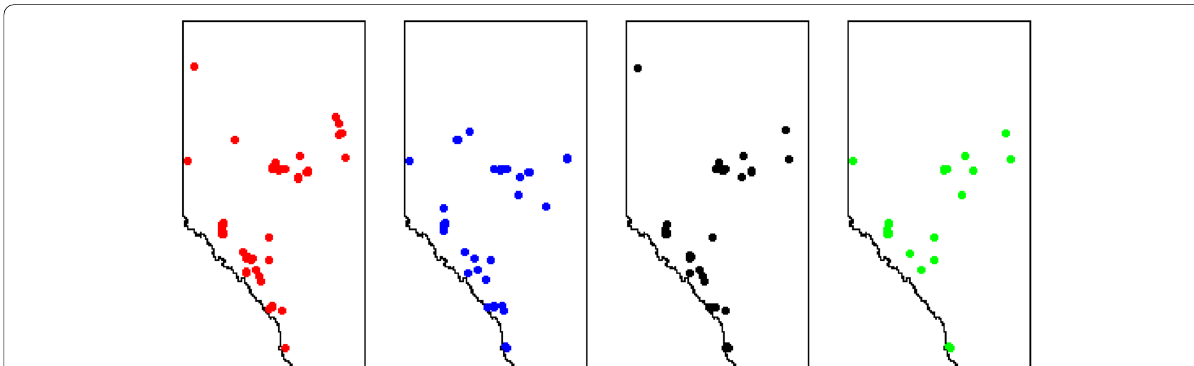
Fig. 2 Locations of observations in each of the four fuel class clusters (FCCs). Stand FCC membership is denoted by red, blue, black, and green colour reference